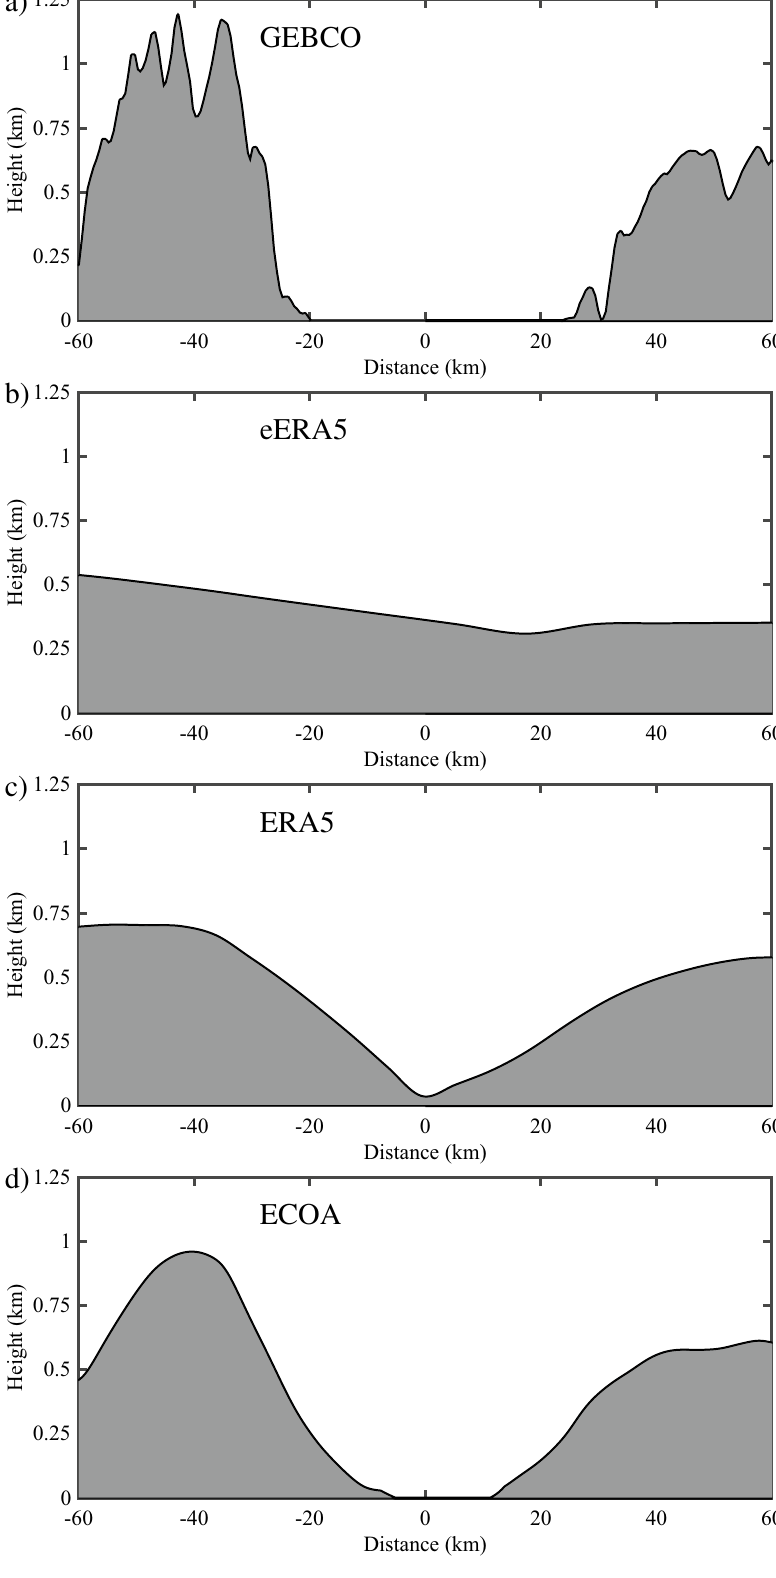
Figure 4. Cross-section through the topography normal to Nares Strat in the vicinity of Hans Island for the: (a) GEBCO digital elevation model, (b) eERA5; (c) ERA5 and (d) ECOA. Negative distances are to the northwest of Hans Island with positive distances to the